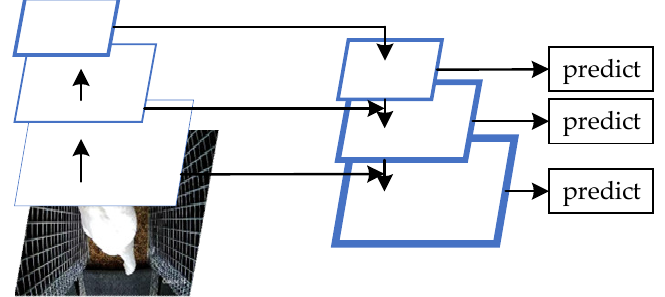
Figure 5. Characteristic pyramid network diagram.